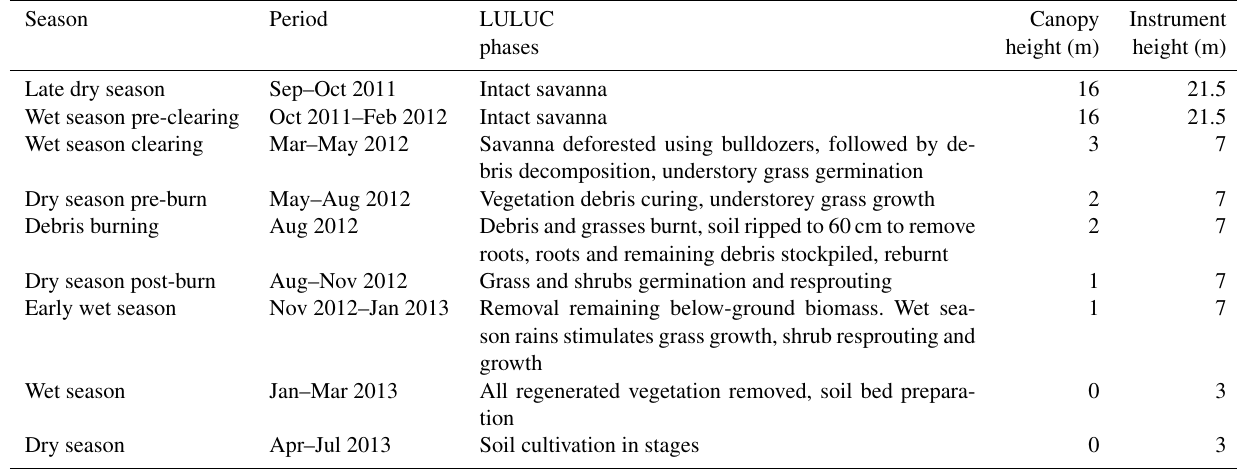
Table 2. Characteristics of land conversion phases during the 668-day observation period at the savanna clearing site (CS). Also given are the canopy heights following LUC phases and flux instrument heights that were adjusted following clearing, burning and then soil preparation